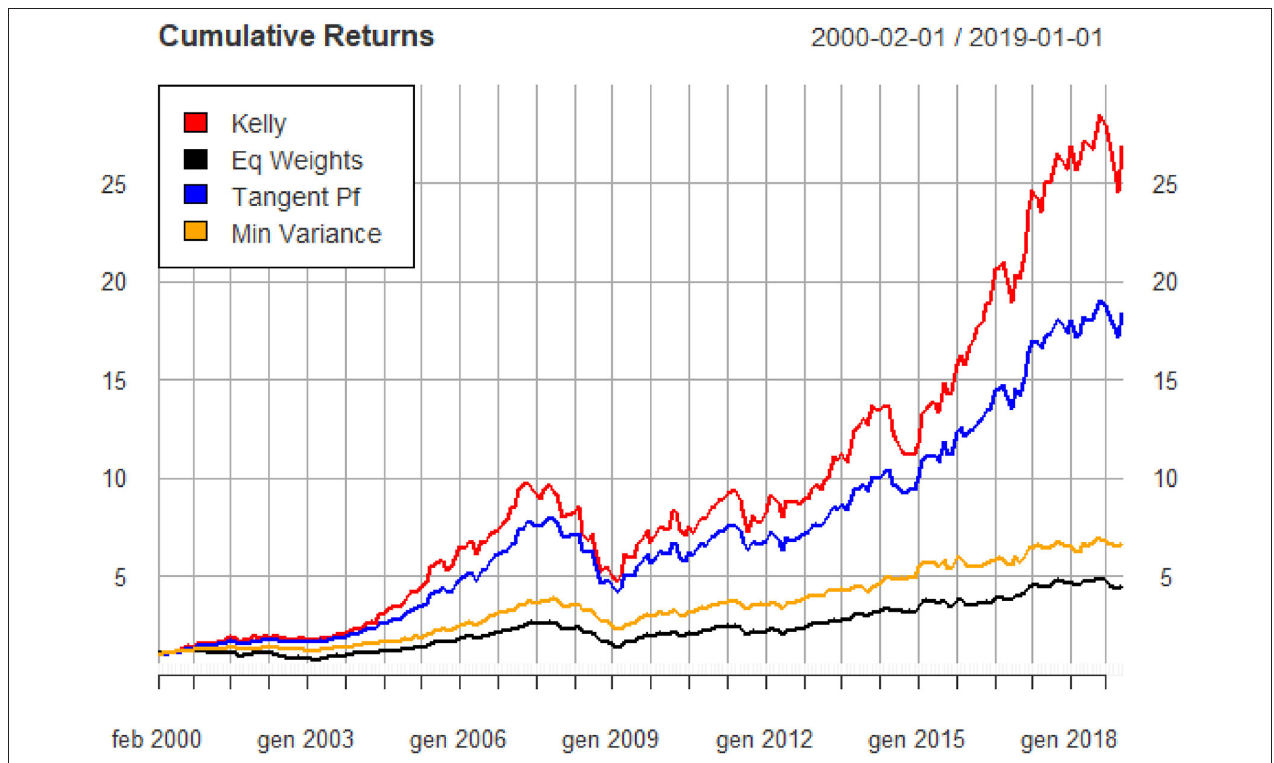
FIGURE 5 | In-sample cumulative returns of portfolios (monthly